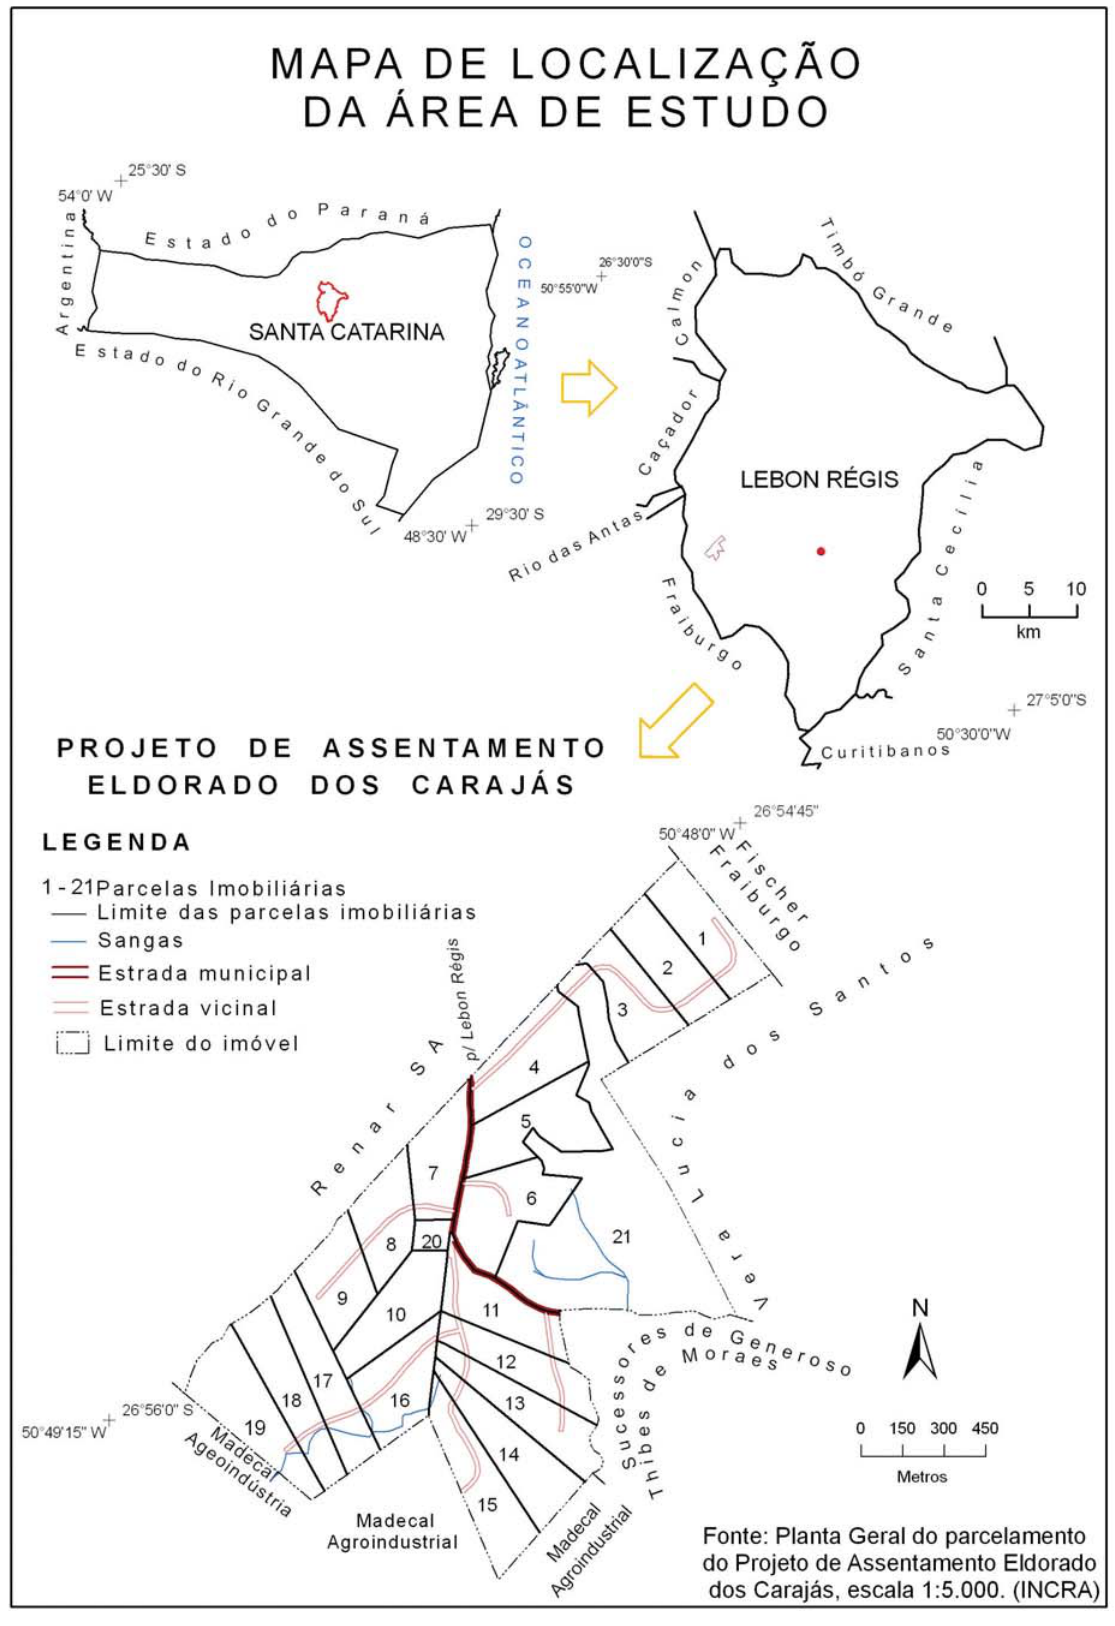
Figura 1. Mapa de localização da área de